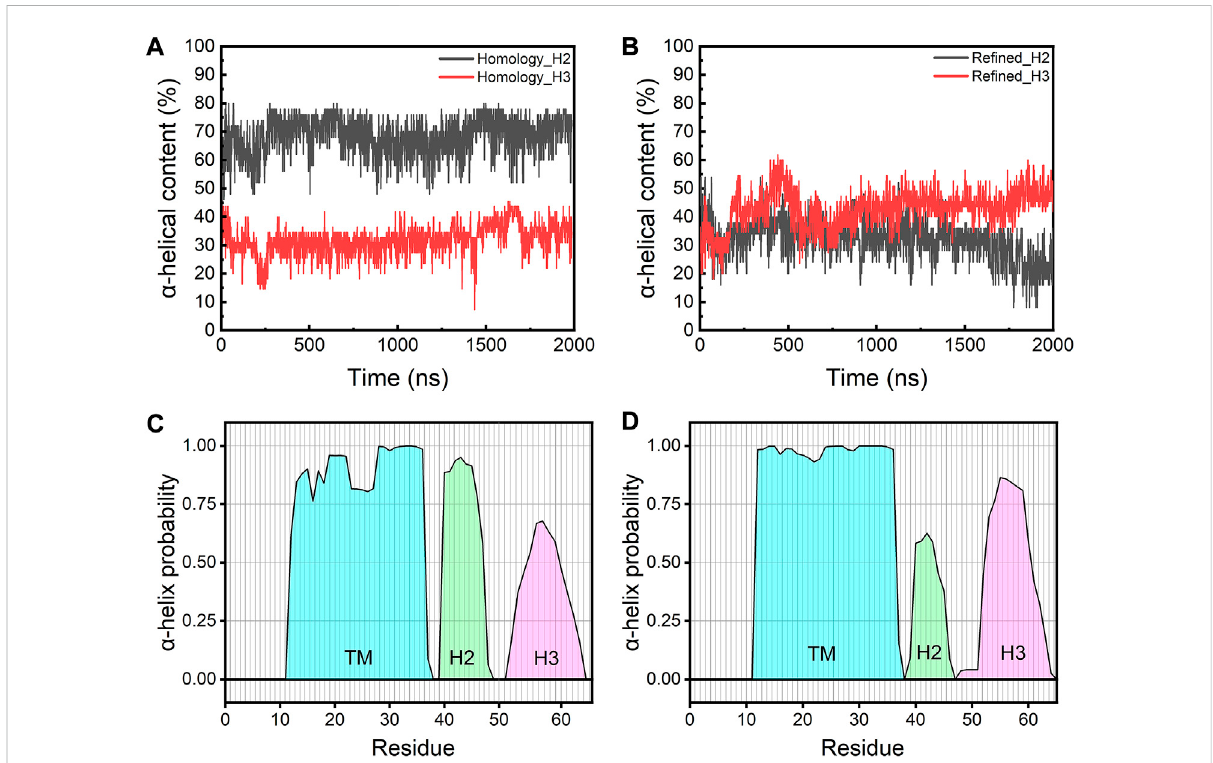
FIGURE 4 Time-evolutionof α -helicalcontentofH2sandH3sin (A) thehomologyand (B) there fi nedmodel.Averageprobabilityofthe α -helicalstructure for each residue from simulations of (C) the homology model and (D) the re fi ned model. Cyan: TM regions; green: H2 helices; magenta: H3